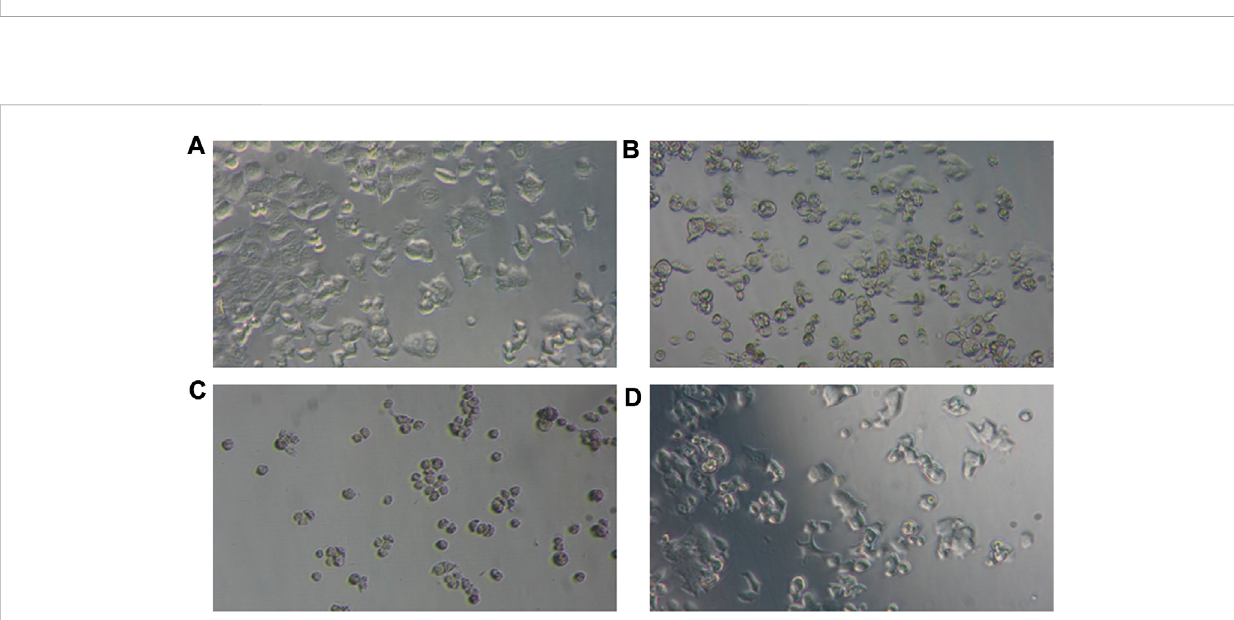
FIGURE 7 Photomicrographs of the cellular morphology of (A) untreated MCF-7 and the changes induced by (B) cisplatin, (C) Cr1 , and (D) Cr2 using 50 μ M.